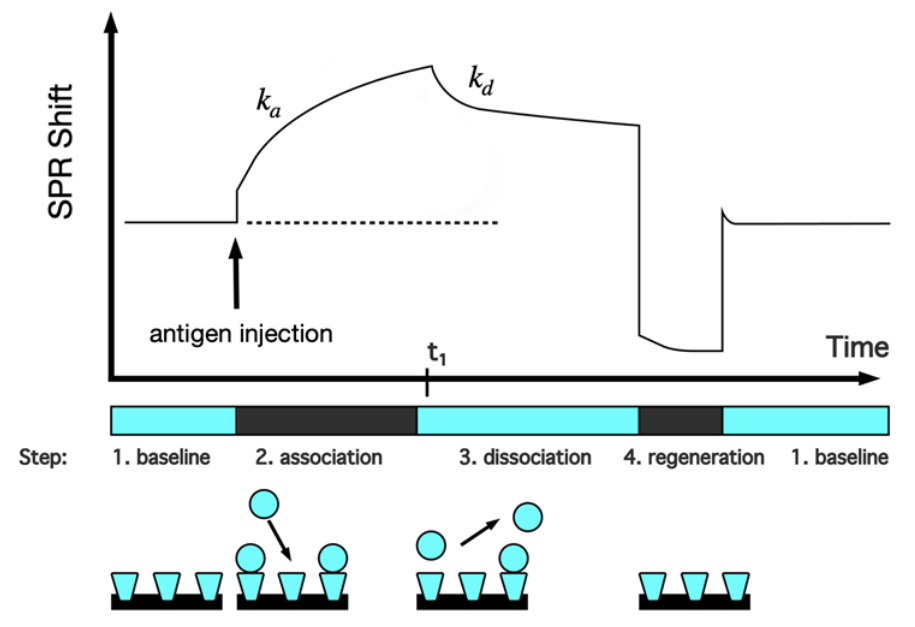
Figure 7. A generic cycle (sensogram) for an antigen assay including: (1) the baseline signal with no antigens present; (2) the association stage where antigens bind to the antibody; (3) the dissociation stage where some antigens are dislodged with a constant rate; and (4) the regeneration stage where the antigens are removed by spiking with pH generating the new baseline. Adapted from Ref. [210] with written permission of Dr. Richard B.M. Schasfoort.